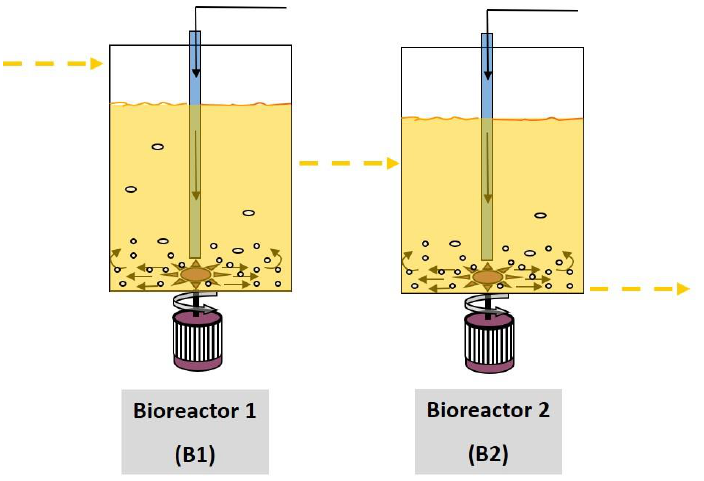
Figure 1. Two identical serially arranged bioreactors working in a repeated semi-continuous mode for the production of wine vinegar. for the production of wine